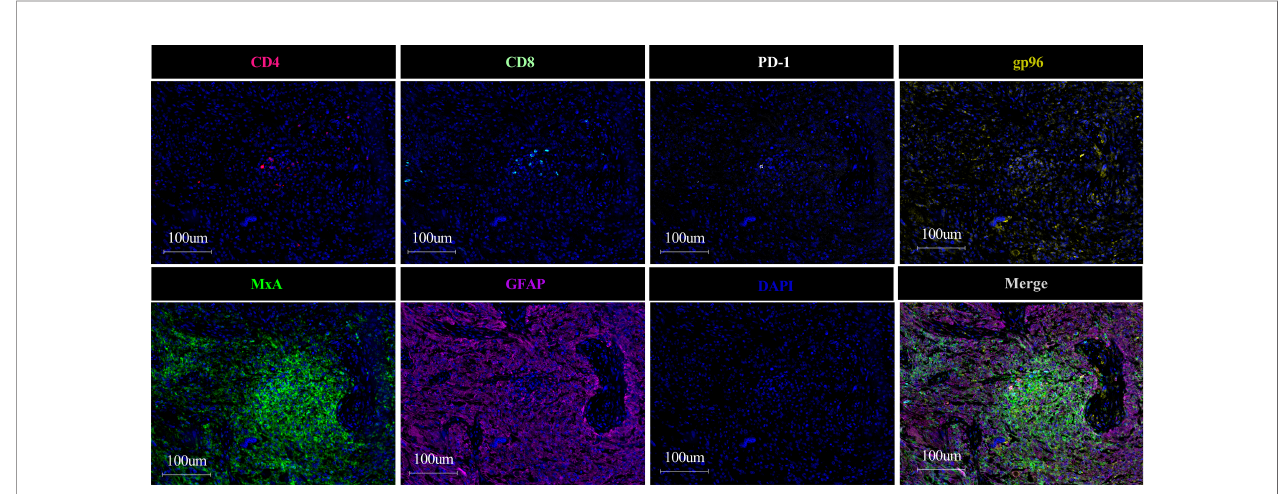
FIGURE 1 | Representative staining of CD4+, CD8+, and PD-1+ cells and gp96 and MxA in GBM